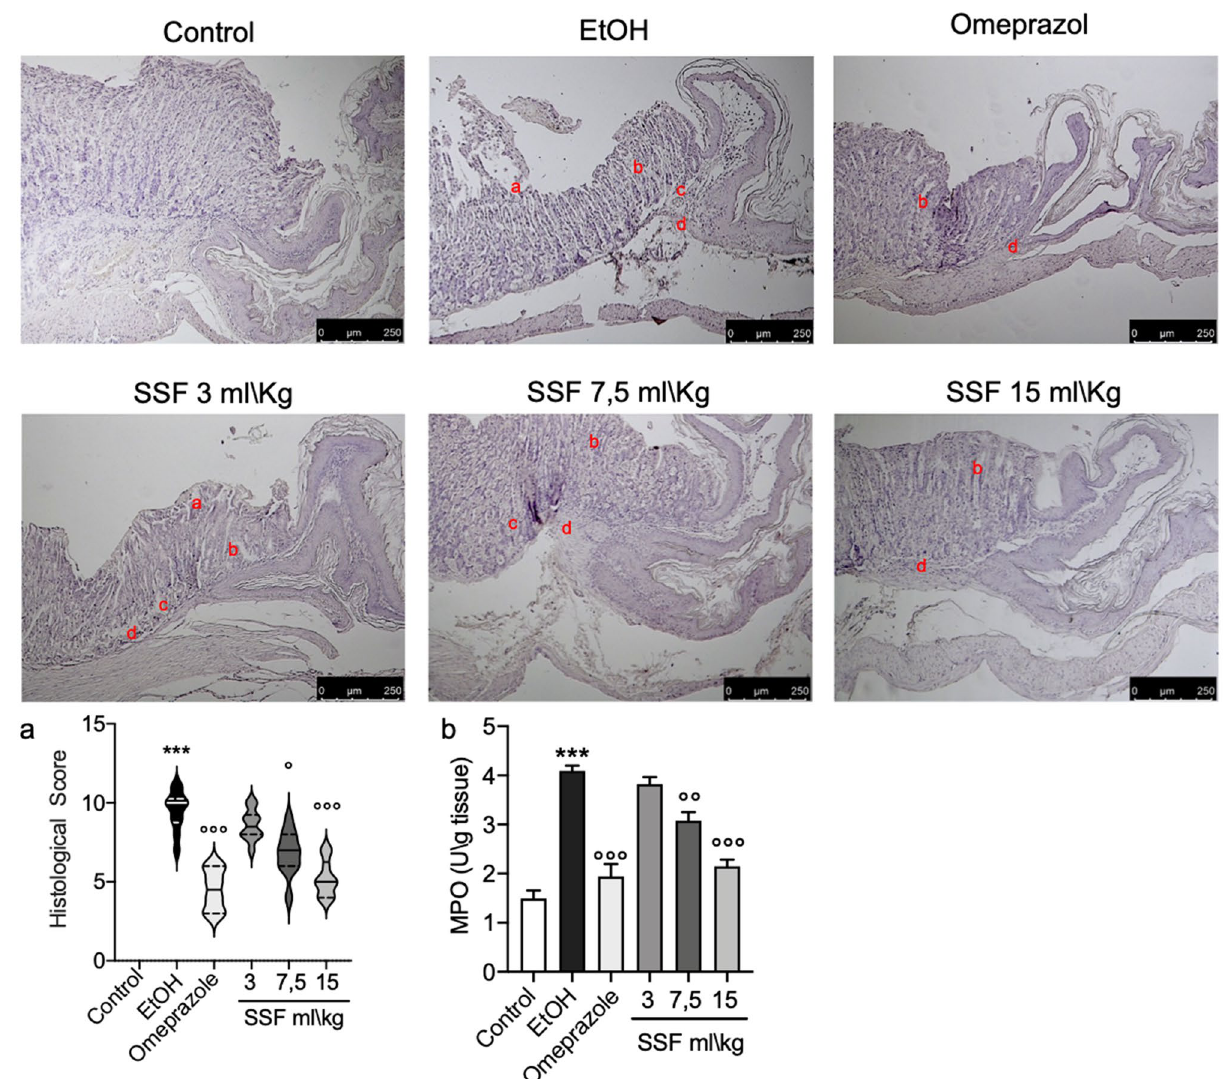
Figure 3. Stomach tissue section from: Control group healthy mice; EtOH group negative control; omeprazole 20 mg/kg positive control group; Histological section was assessed for: a) epithelial cell loss; b) edema in the upper mucosa; c) hemorrhagic damage; d) presence of inflammatory cells. The treatment with SSF showed a dose dependent protective effect SSF 3 ml/kg by os; SSF 7.5 ml/kg by os; SSF 15 ml/kg by os. Panel b showed the resuts of MPO assay. Data are presented as means ± SEM, or median with interquartile range for non-parametric data of 10 mice for each group.***p < 0.001 versus control; ◦ p < 0.05 versus EtOH; ◦◦ p < 0.01 versus EtOH; ◦◦◦ p < 0.001 versus